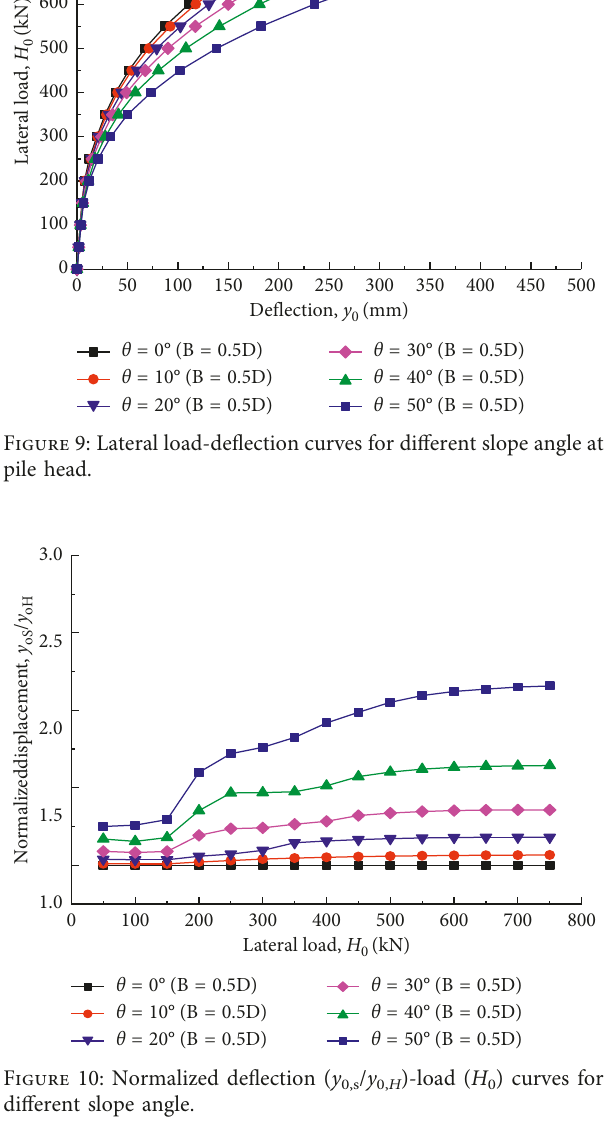
0,s / y 0, H )-load ( H 0 ) curves for Figure 12: Bending moment variation along the depth of pile for different slope angle.